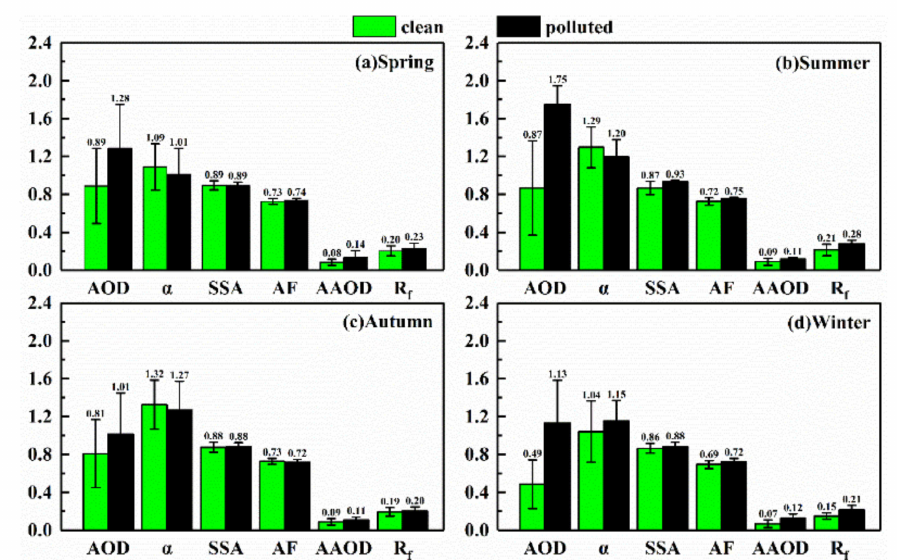
Figure 4. Multi-year seasonal mean of aerosol optical properties in ( a ) spring; ( b ) summer; ( c ) autumn; ( d ) winter over Wuhan, China from 2013 to 2016. All parameters shown in this figure are at 440 nm except for α . The digital labels indicate the average values of aerosol optical parameters, and the vertical bars correspond to one standard deviation from the